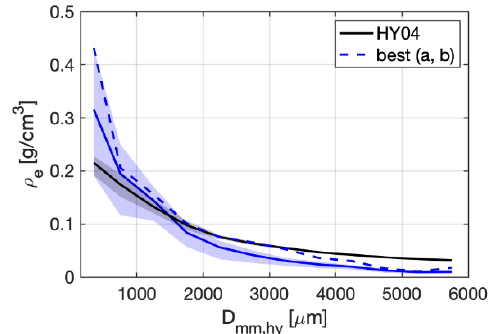
Figure 3. E ff ective density ( ρ e ) determined by di ff erent m–D relations. The blue solid line, lower bound and upper bound of the blue shading areas represent mean values, 25% and 75% percentiles of ρ e respectively. Blue dashed line indicates the ρ e derived from the best estimate of ( a , b ) that minimizes χ 2 in each D mm , hy bins. Black line denotes ρ e derived from the HY04 m–D relationship.